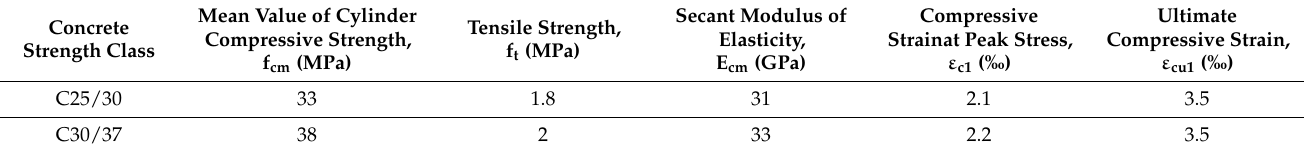
Table 3. Characteristics of concrete in Figure 11.